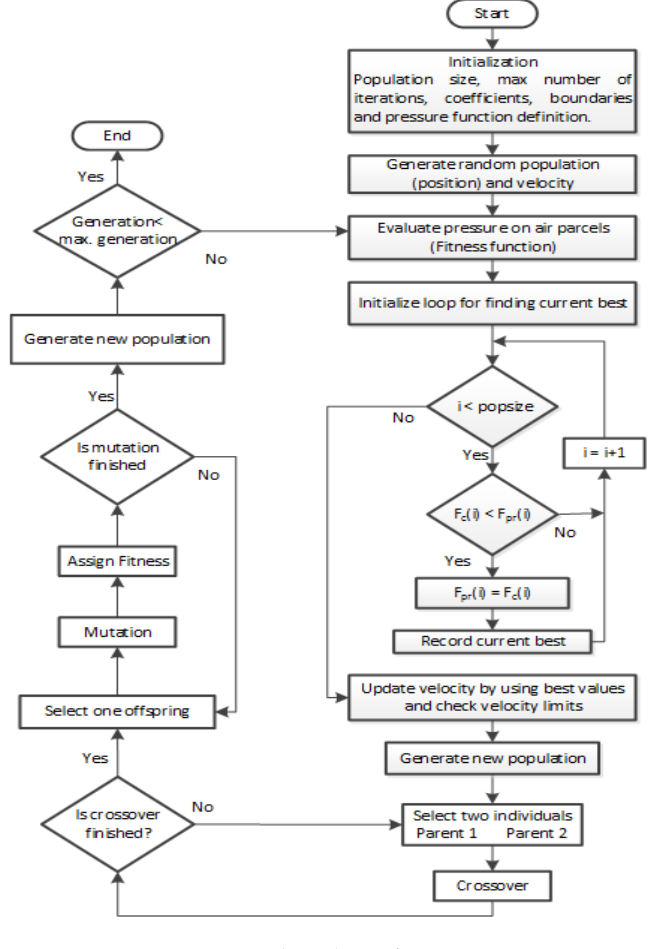
Figure 8. Flow chart of